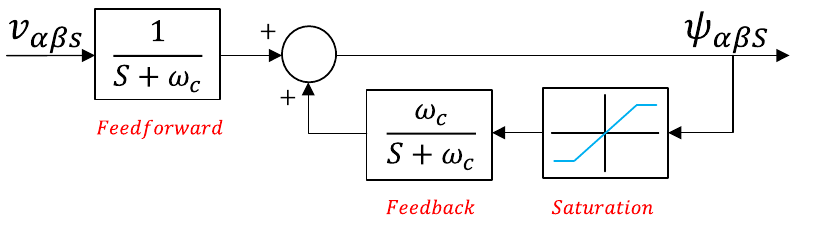
Figure 7. Modified integrator with a saturable